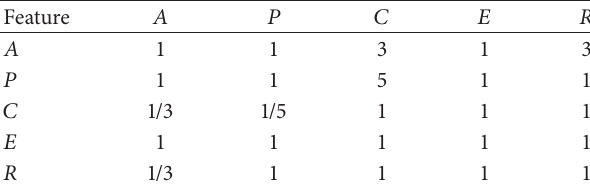
Table 3: The weight ratio between characteristic